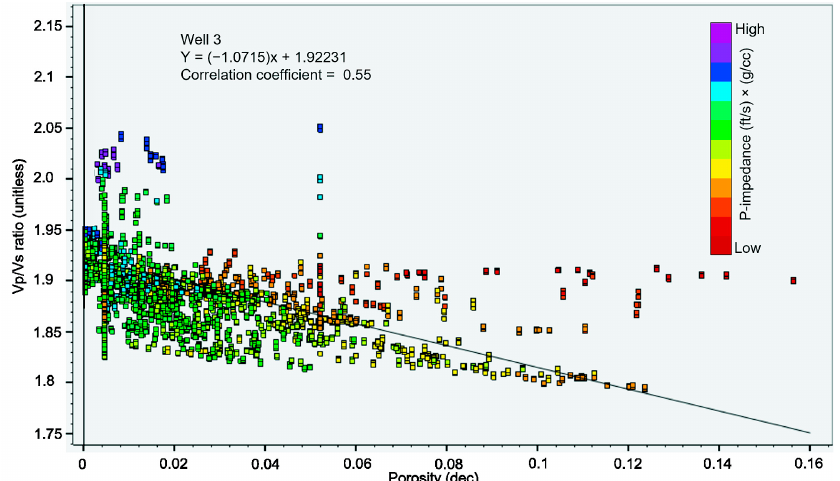
Figure 17. Cross plot of porosity versus Vp/Vs ratio color coded with impedance for wells 1, 2, 3, and 5, showing that Vp/Vs ratio decreases as porosity increases. Note: correlation coefficient = 0.74.